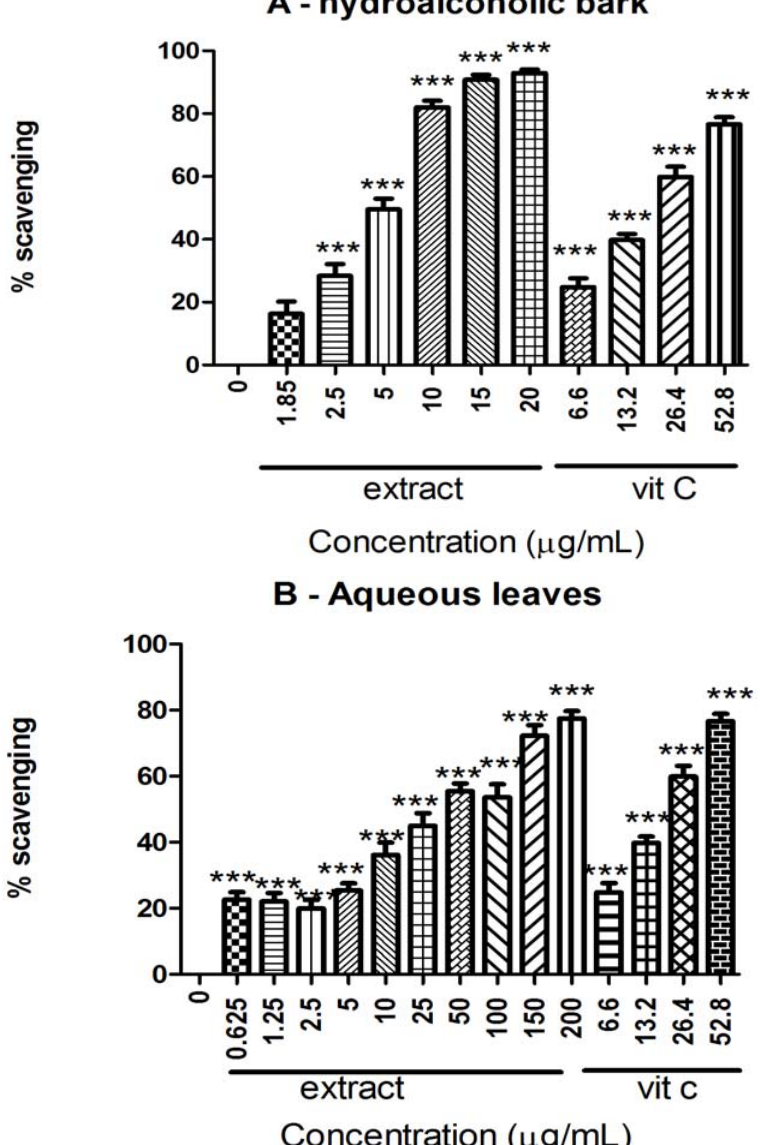
Figure 4. DPPH radical scavenging activity by extracts from S. rotundifolium : ( A ) hydroalcoholic extract of bark; ( B ) aqueous extract of leaves; ( C ) aqueous extract of bark. The results are expressed as percentage of inhibition and ascorbic acid was used as a positive control. Data show means ± SEM values average from 3 to 4 independent experiments performed in triplicate. *** p < 0.001 vs .